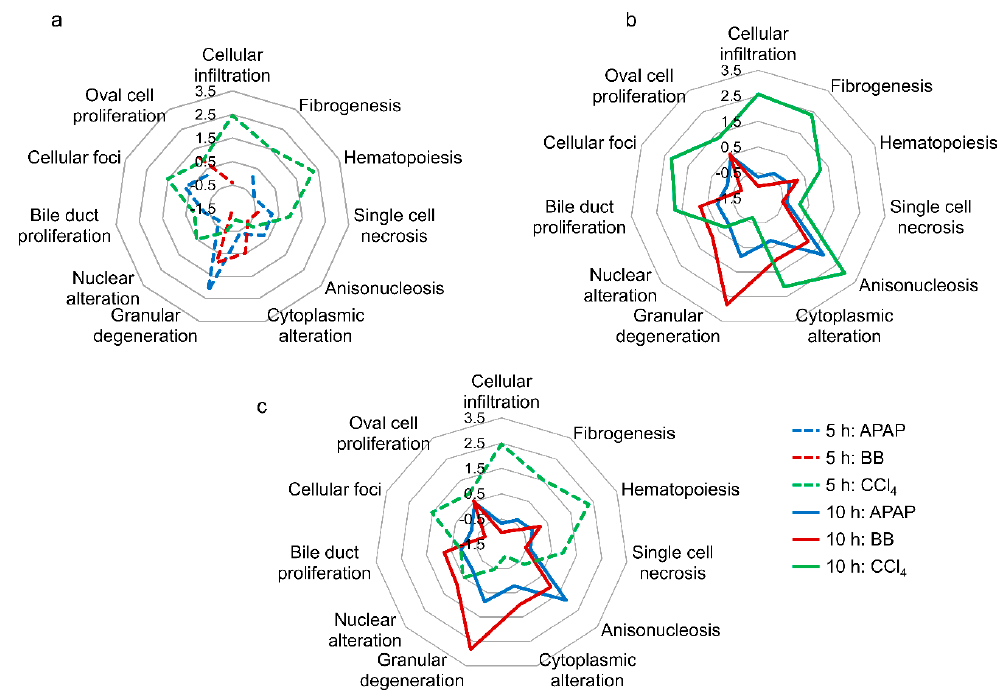
Figure 4. Radial diagrams indicating liver injury phenotypes (histopathology) based on significantly altered genes identified for each toxicant (FDR < 0.1). Liver injury module z-score values at ( a ) the 5 h time point (dashed lines), ( b ) at the 10 h time point (solid lines), and ( c ) based on the time points at which peak alterations are observed in liver gene expression.